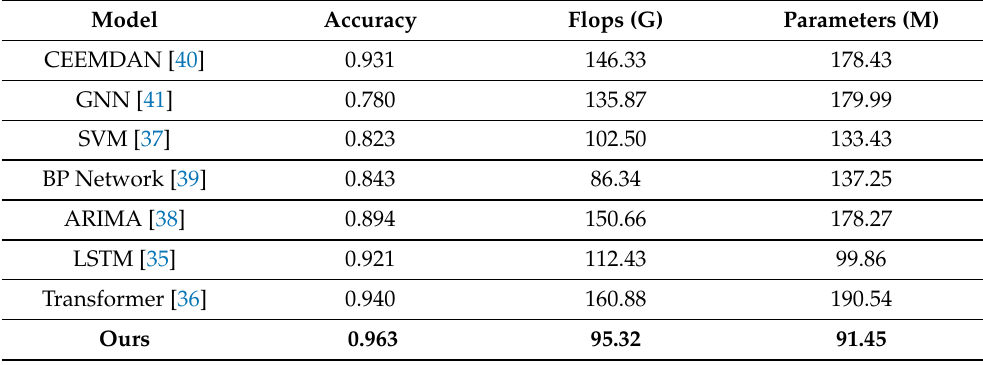
Table 2. A comparison of the different